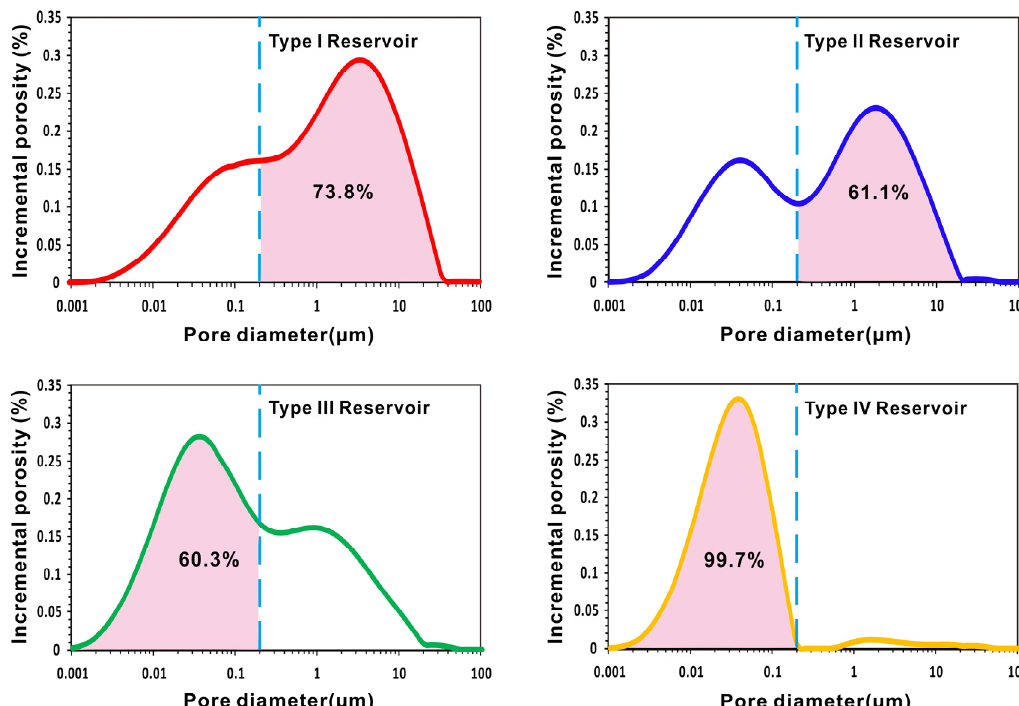
Figure 13. NMR pore size distributions of different types of reservoirs.